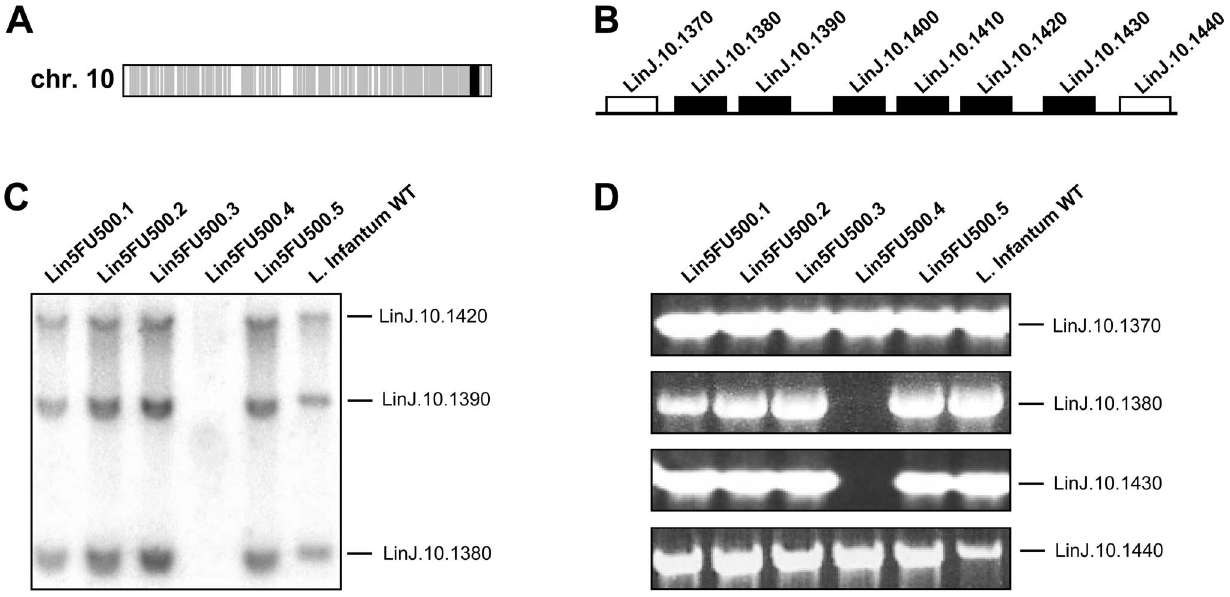
Figure 2. Locus deletion on chromosome 10 in the Lin5FU500.4 mutant. ( A ). Comparative genomic hybridization (CGH) experiments between Lin5FU500.4 and the WT strain. Grey, equal amount of DNA between the strains; black, decrease in the copy number of 5 genes clustered on chromosome 10 was observed in Lin5FU500.4. ( B ). Schematic representation of the 5 genes part of the locus deleted. The white boxes represent the two genes ( LinJ.10.1370 and LinJ.10.1440 ) flanking the deleted locus on chromosome 10. Black boxes represent the six genes deleted. ( C ). Southern blot co-hybridized with three different probes (indicated on the right) specific for genes deleted in the Lin5FU500.4 mutant as determined by CGH. ( D ). PCR amplification of genes outside ( LinJ.10.1370 and LinJ.10.1440 ) or within ( LinJ.10.1380 and LinJ.10.1430 ) the region deleted in Lin5FU500.4 in the various 5FU mutants.